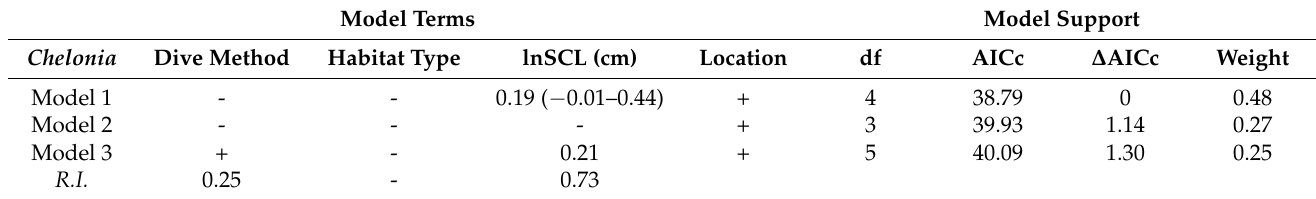
Table 3. Confidence set for linear mixed effects model examining the relationship of green sea turtle minimum approach distance and biological factors ( ∆ AICc < 2). Note: (+) symbol indicates variable was included in the model and (-) indicates variable was not included in the model. AICc = Akaike’s Information Criterion corrected for small sample size, ∆ AICc = difference in AICc from the top ranked model, R.I. = relative importance.